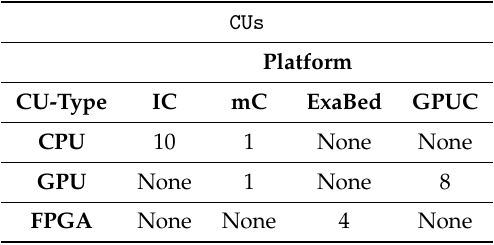
Table 2. The compute units , as defined in Section 3, available on the